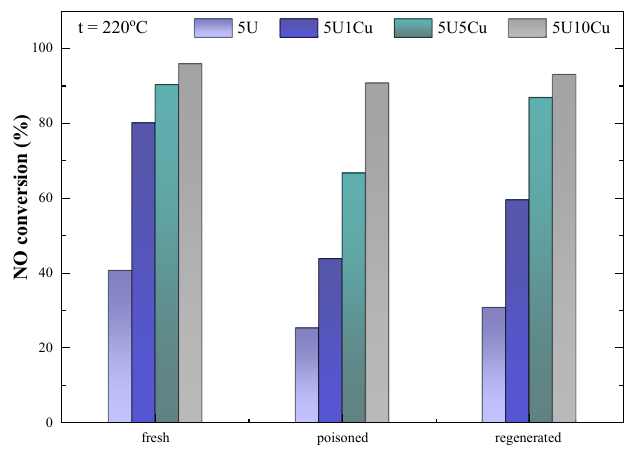
Figure 10. Comparison of the catalytic activity of 5U, 5U1Cu, 5U5Cu, 5U10Cu at 220°C.